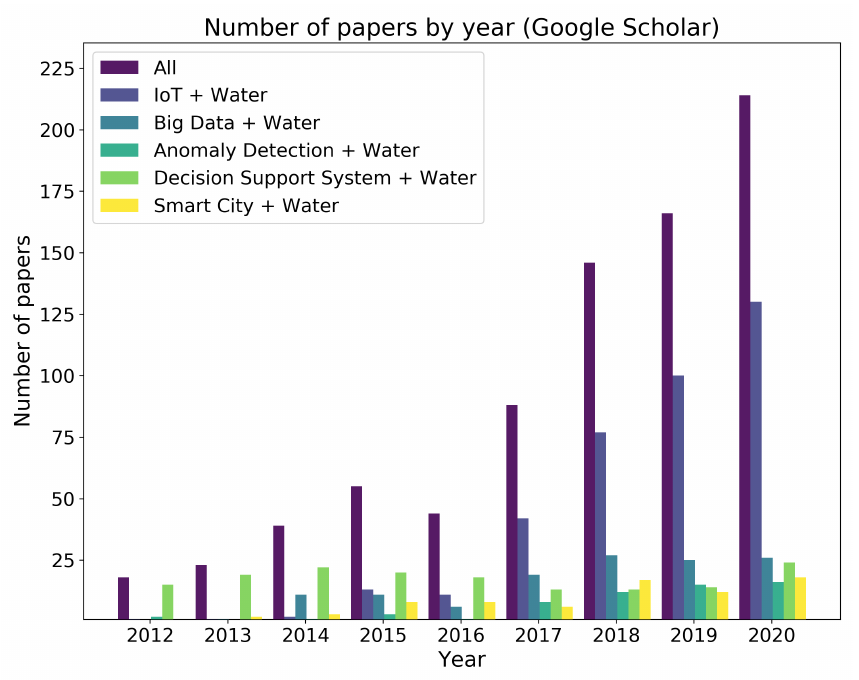
Figure 1. Number of papers related to the topics of interest by year published.